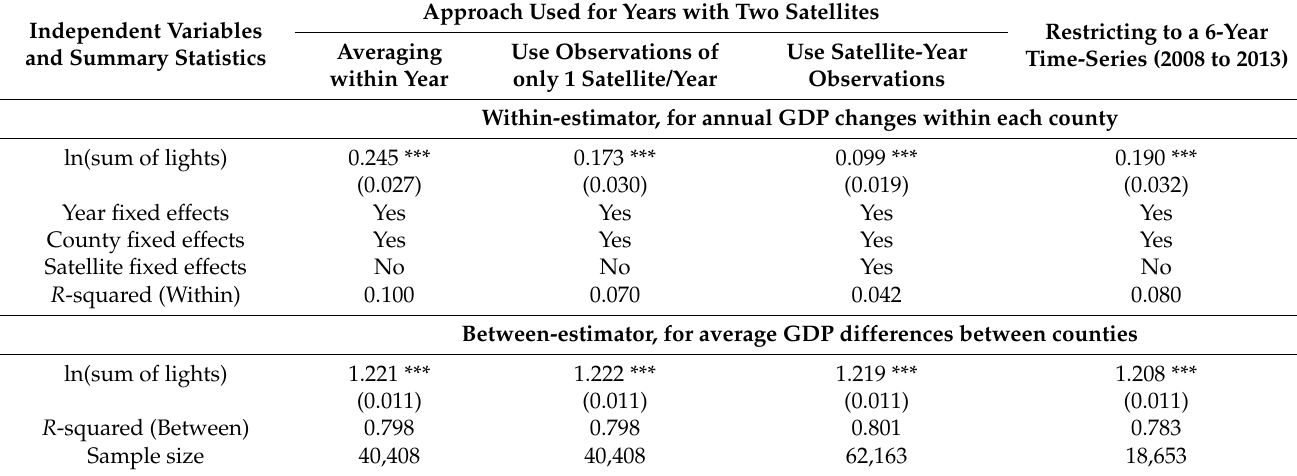
Table 5. Relationships between DMSP NTL and county GDP: within- and between estimator results. Independent